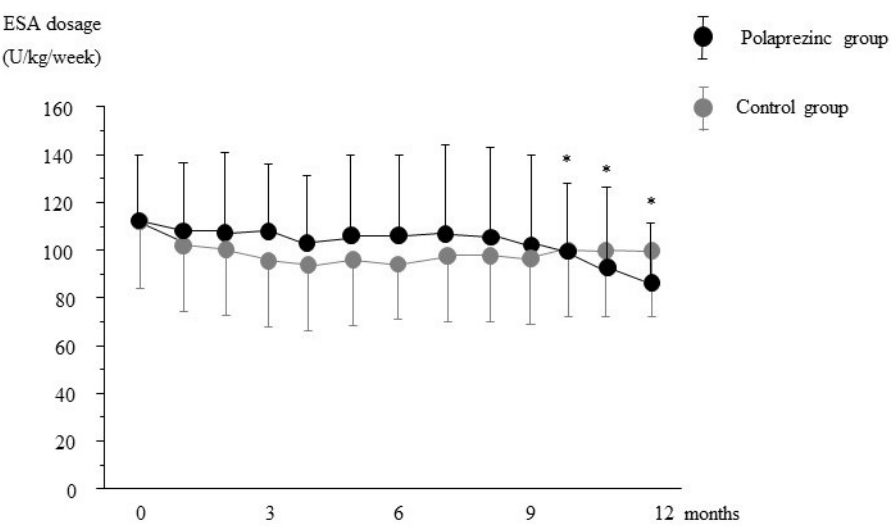
Figure 2. Changes in the required weekly recombinant human erythropoietin dosage during the study period. ESA, erythropoiesis-stimulating agent, Data are expressed as mean ± SD, * p < 0.05 vs. baseline.